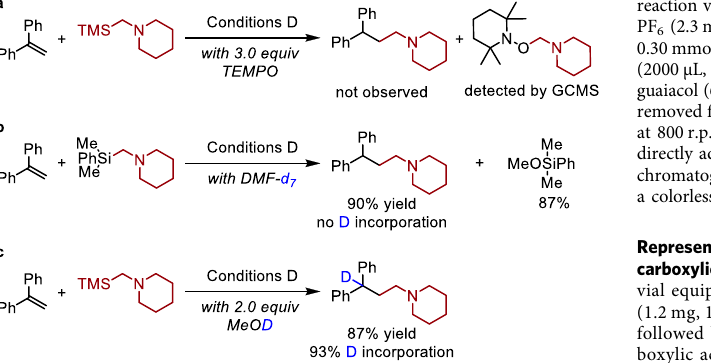
Fig. 6 Mechanistic investigations. a Control experiments with TEMPO. b Deuterium-labeling studies in DMF- d 7 . c Deuterium-labeling studies with MeOD. See Fig. 4 legend for Conditions D.